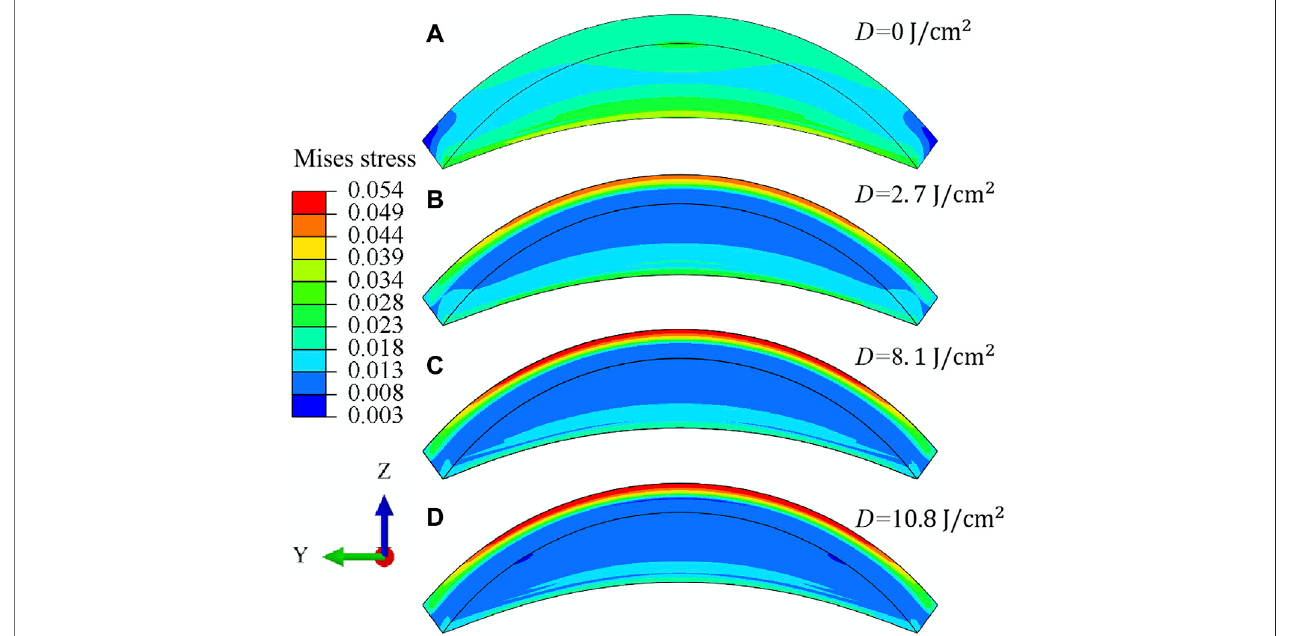
FIGURE 8 | Meridional N-T sectional view (A – D) of the Mises stress (unit in MPa) distribution for porcine cornea when the IOP equals 30 mmHg. The irradiation dose increases from 0J/cm 2 to 10 . 8J/cm 2 .